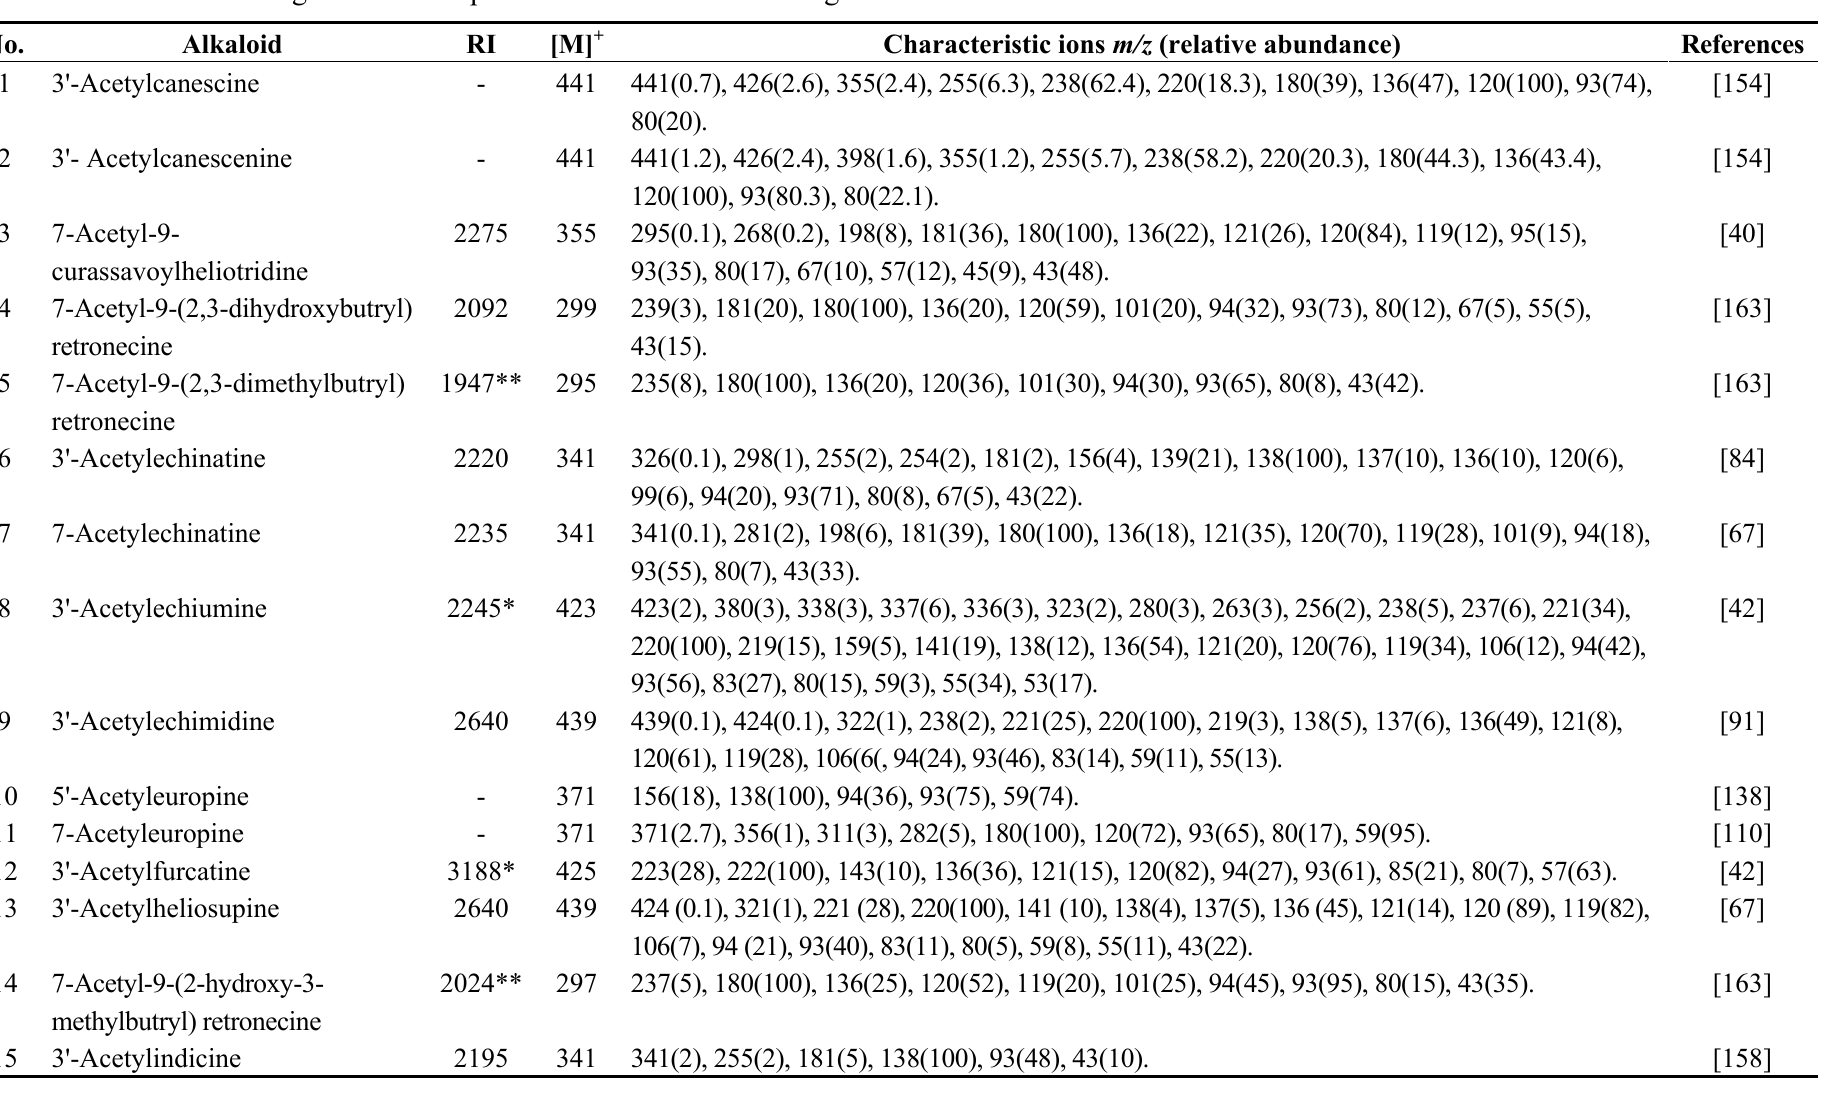
Table 3. Mass data of PAs (mostly derived from gas-liquid chromatography-mass spectrometry (GLC-MS) analyses) for all compounds identified in the Boraginaceae. Compounds are numbered as in Figure